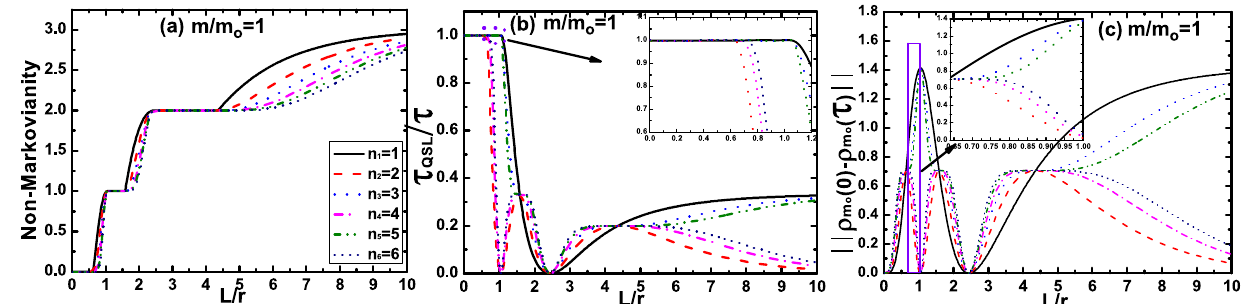
( 0 ) = 1 ( |↑(cid:6) + |↓(cid:6) )( (cid:12)↑ | + (cid:12)↓ | ) to the target final state ρ (τ) ρ s s s s s s 2 ( 0 ) − ρ (τ) (cid:13) a function of L / r . c The geometric distance (cid:13) ρ m for m o hs o different number of particles in the first layer as a function of L / r . Here the actual evolution time τ = 0 . 4s, r =250 µ m and m o =10 − 13